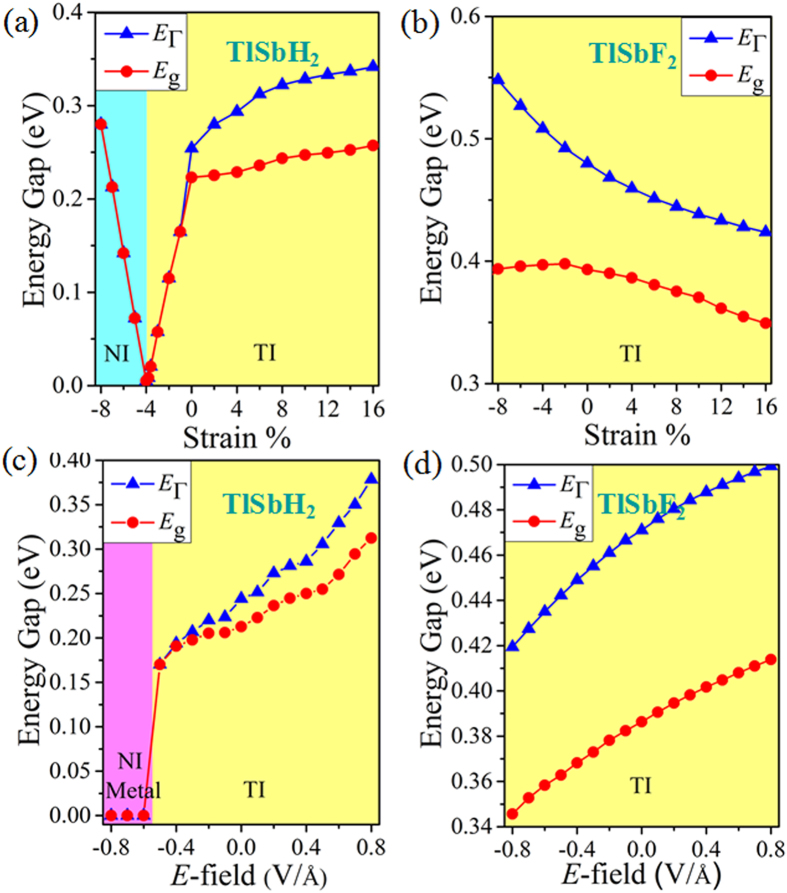
The dependence of band gap of the strain (a) TlSbH2 and (b) TlSbF2, and the electric field (c) TlSbH2 and (d) TlSbF2, respectively.